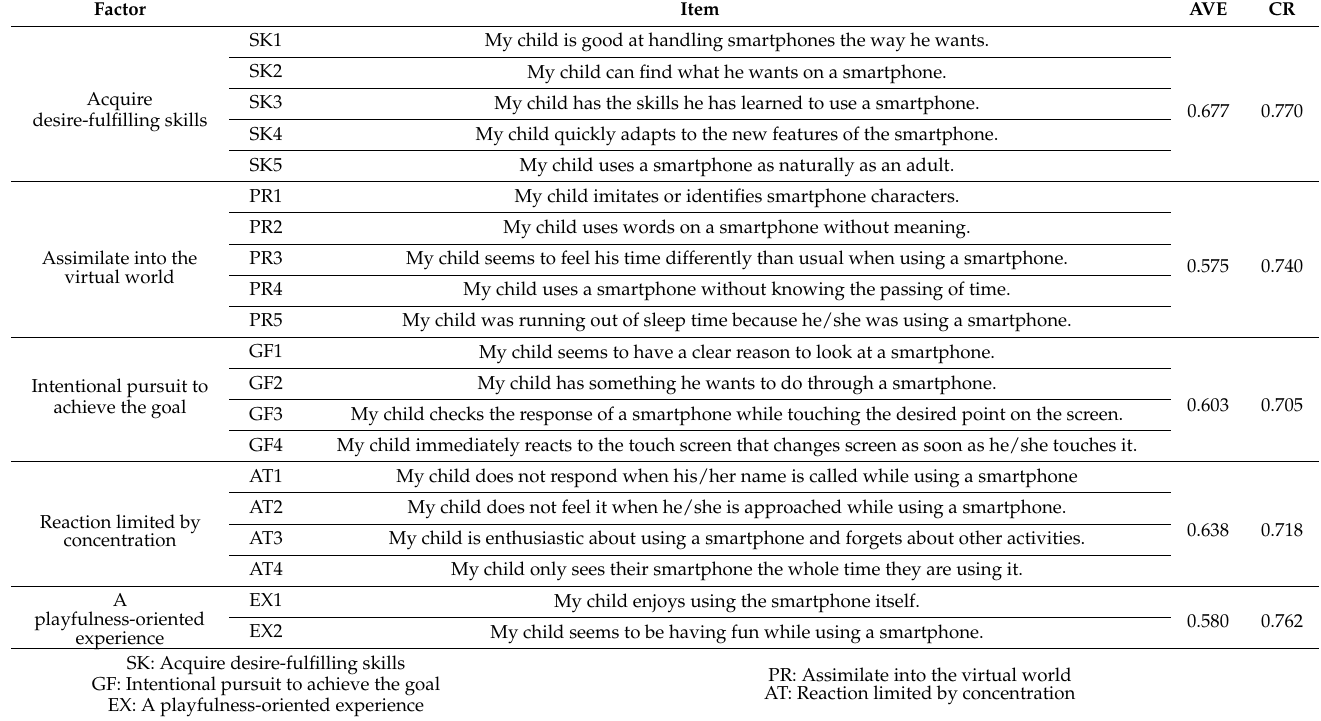
Table 5. Concentrated validity for TS-FSS ( n = 400).